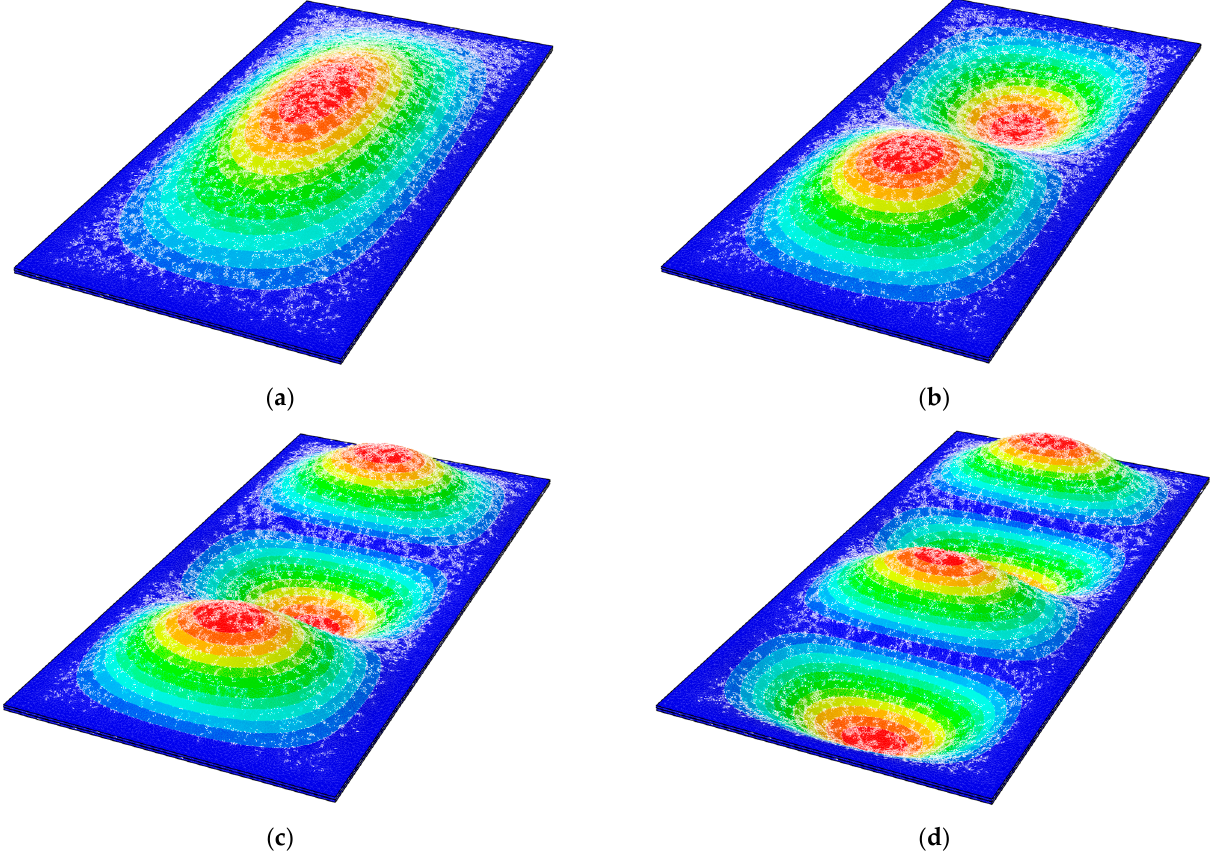
Figure 13. Shape modes for the ( a ) first; ( b ) second; ( c ) third; and ( d ) fourth natural frequencies.